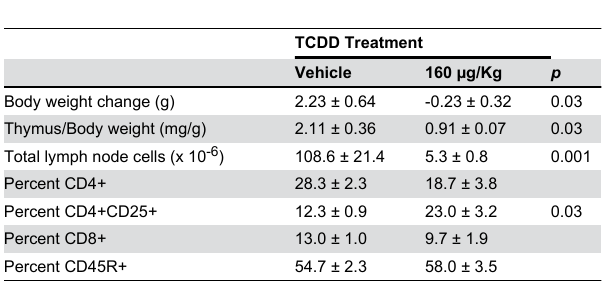
Table 1. TCDD treatment decreased body weight and lymph node cell numbers 26 days after L. major